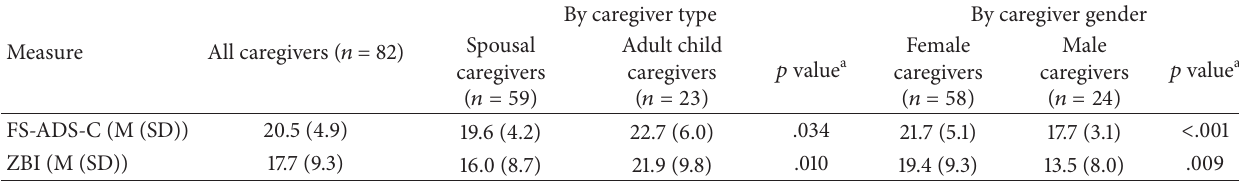
Table 2: Caregiver stigma and burden, by caregiver type and gender.